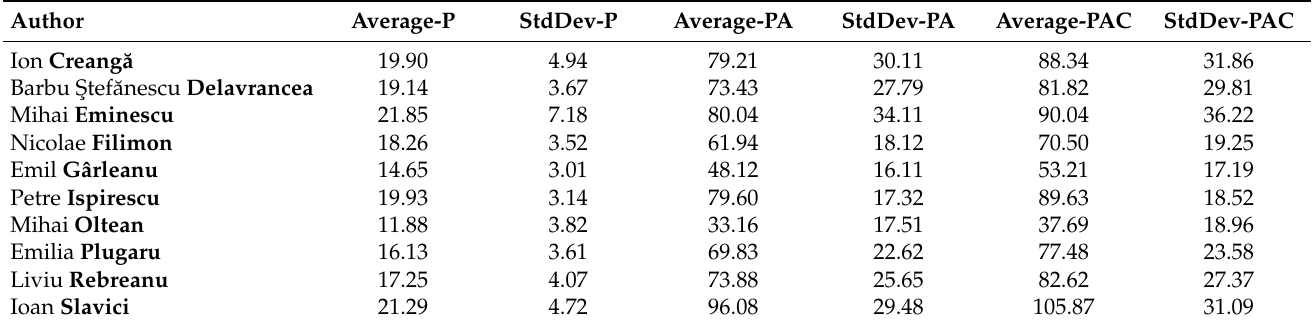
Table 4. Diversity of the considered dataset in terms of the number of occurrences of the